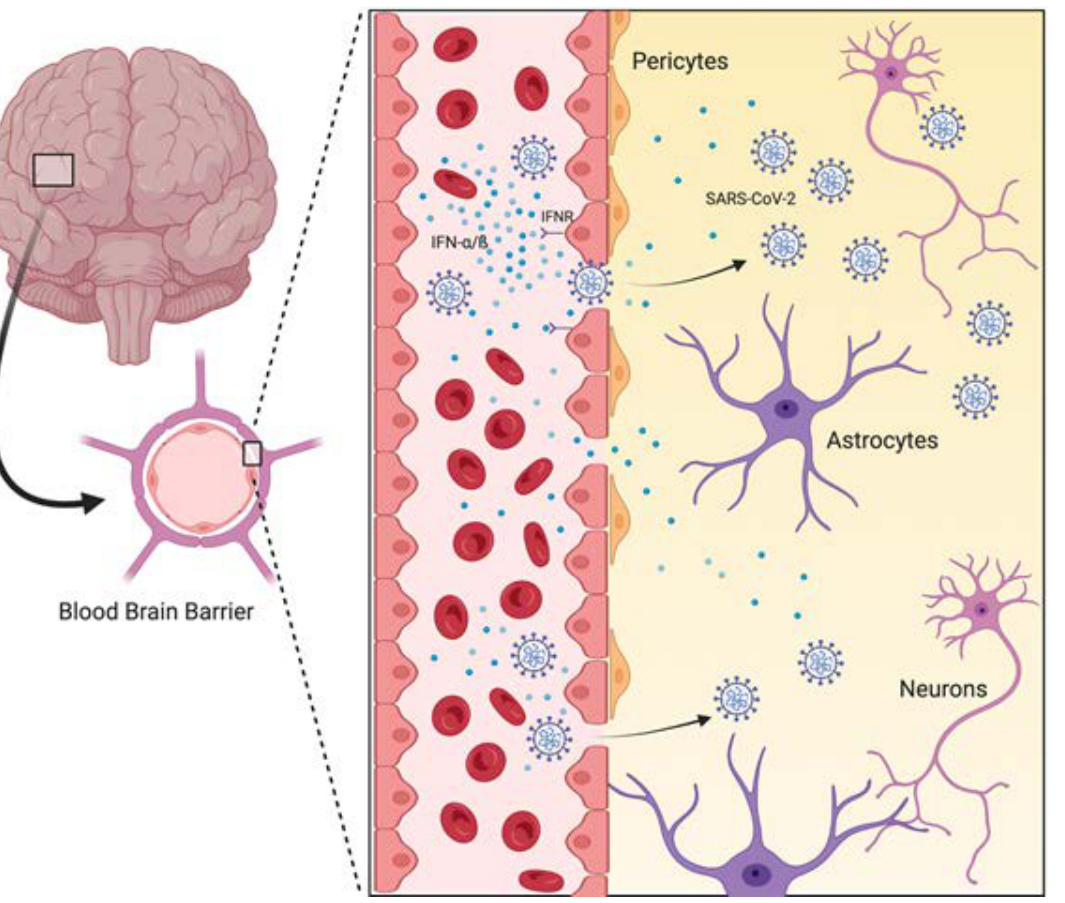
Figure 1. A SARS-CoV-2-infected brain with vessel amplification is depicted. The production of cytokines, such as IFN- α/β and IFNR, initiates the disruption of the blood–brain barrier, after which the virus reaches neurons and astrocytes, initiating an inflammatory process.